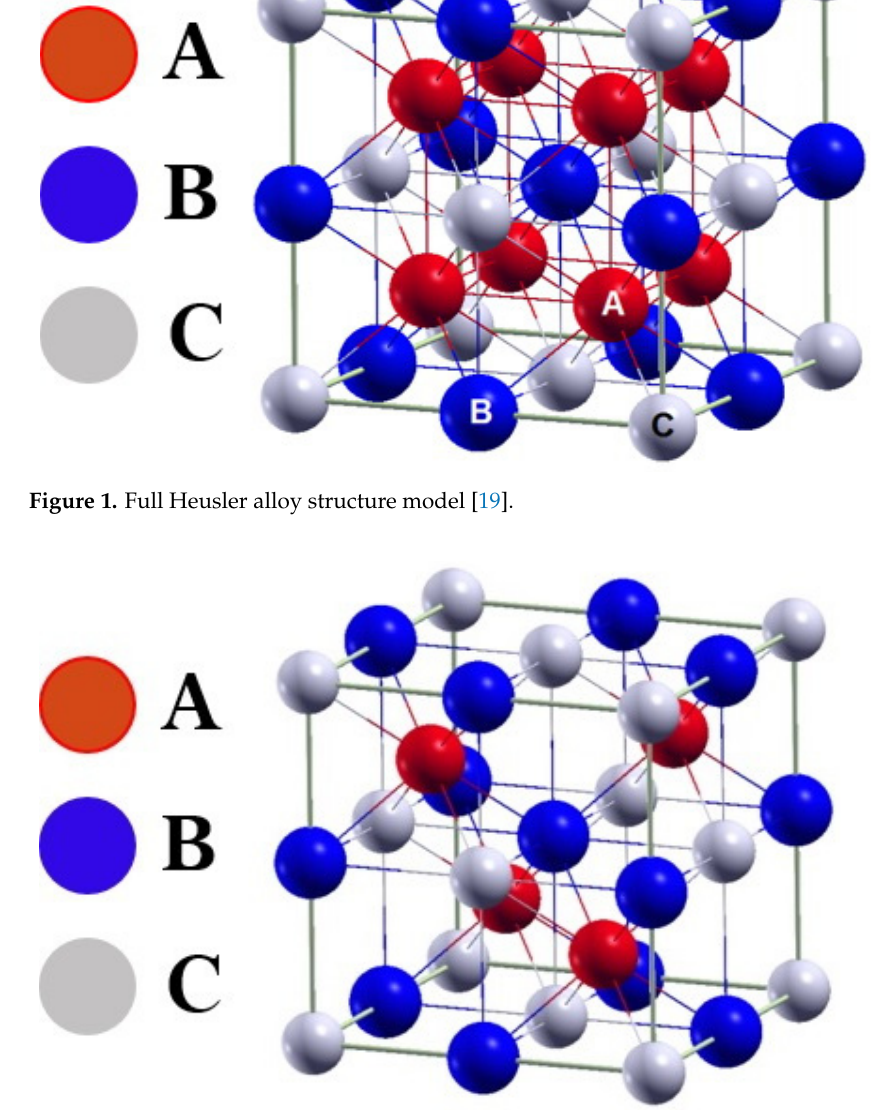
Figure 2. Half-Heusler alloy structure model [20].